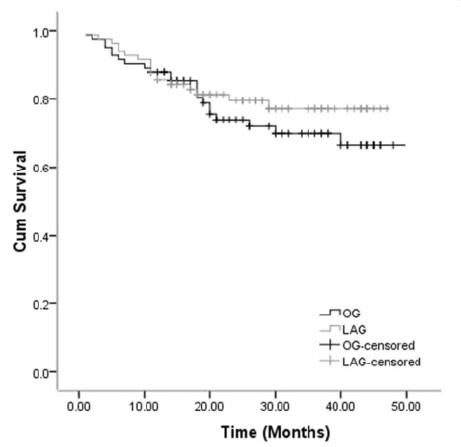
Comparison of cumulative survival rate of laparoscopy-assisted gastrectomygroup and open gastrectomy group by log-rank test (P>0.05).